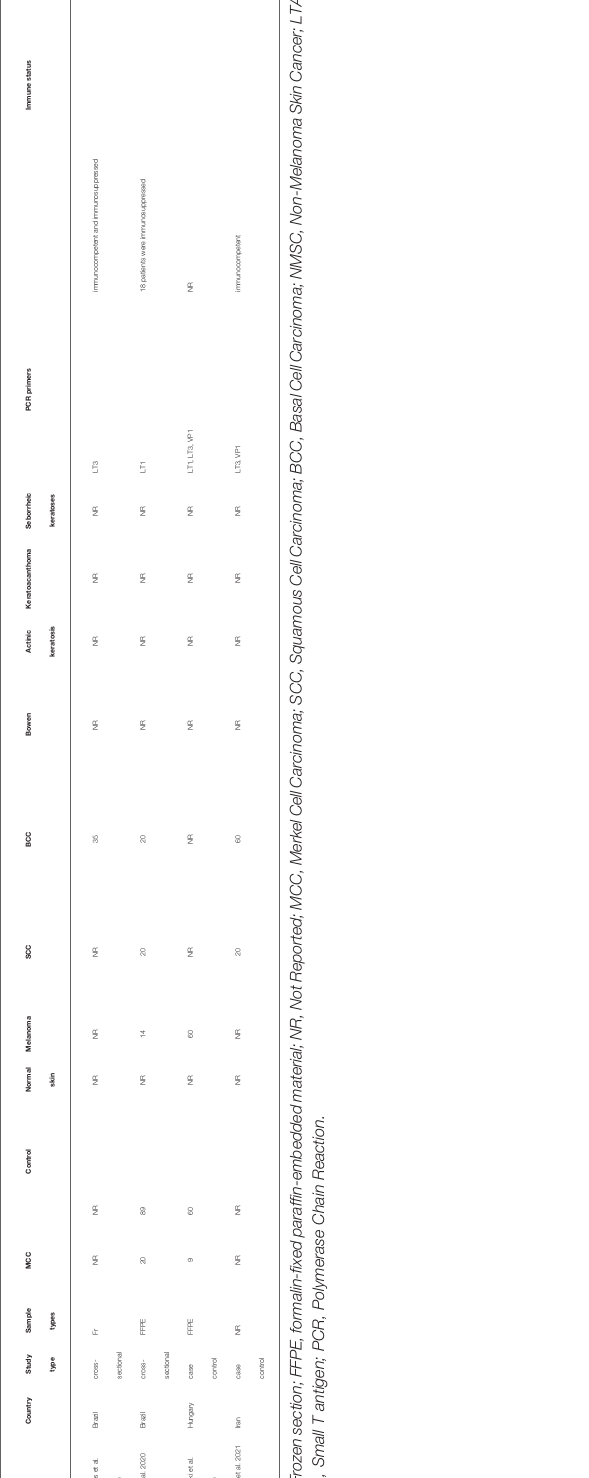
FIGURE 3 | Forest plot illustrating the pooled prevalence rate of the MCPyV positivity in